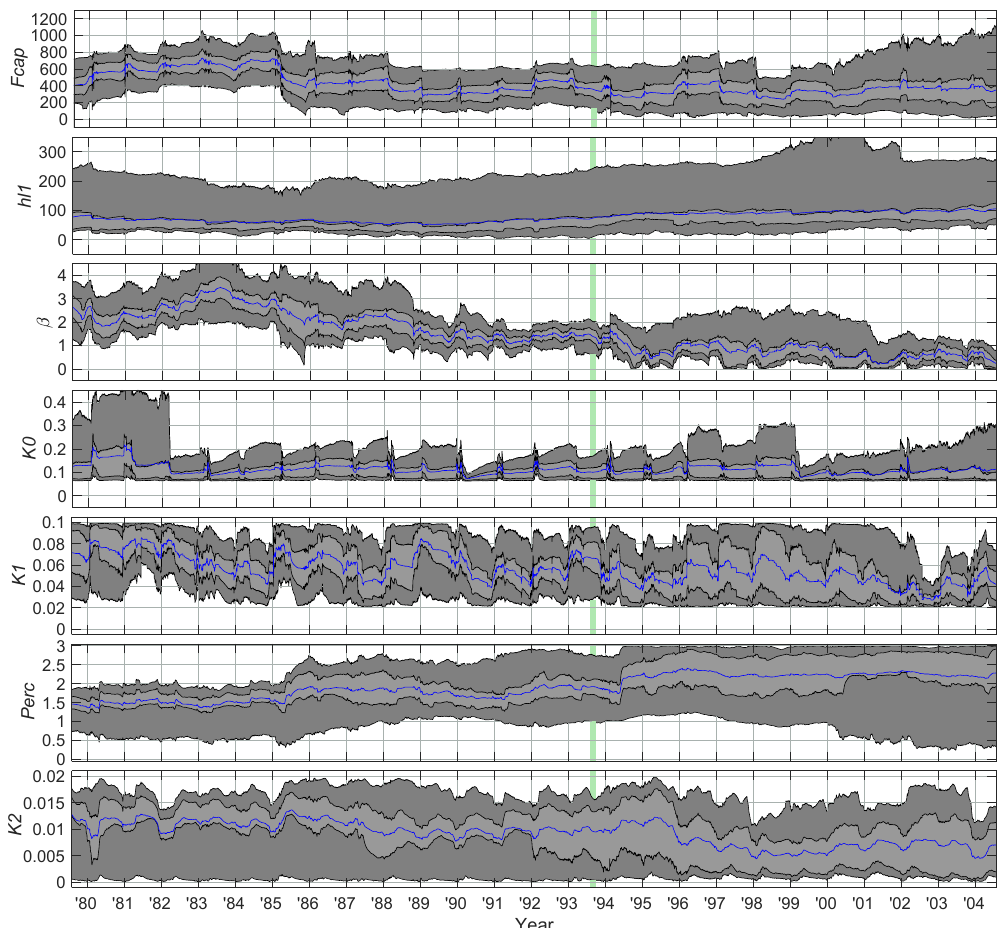
Figure 4. Parameter trajectories using the HBV model. The dark grey shaded areas indicate the middle 90% of the ensemble, bounded by the 5th and 95th percentiles. The light grey shaded areas indicate the middle 50% of the ensemble, bounded by the 25th and 75th percentiles. The ensemble mean is indicated by the blue line. The vertical green panel indicates the assumed time period of rapid